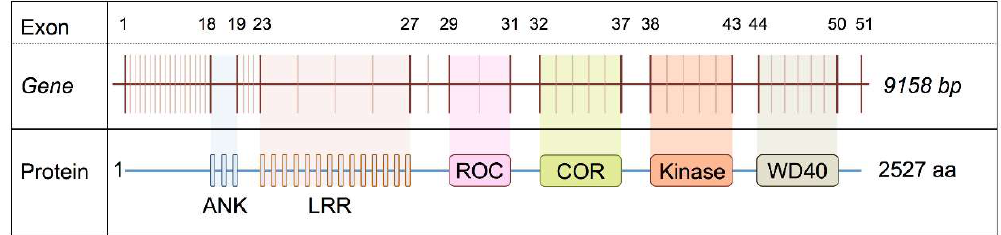
Figure 1. Schematic view shows the physical position for certain exons corresponding to certain functional domains in LRRK2 gene.